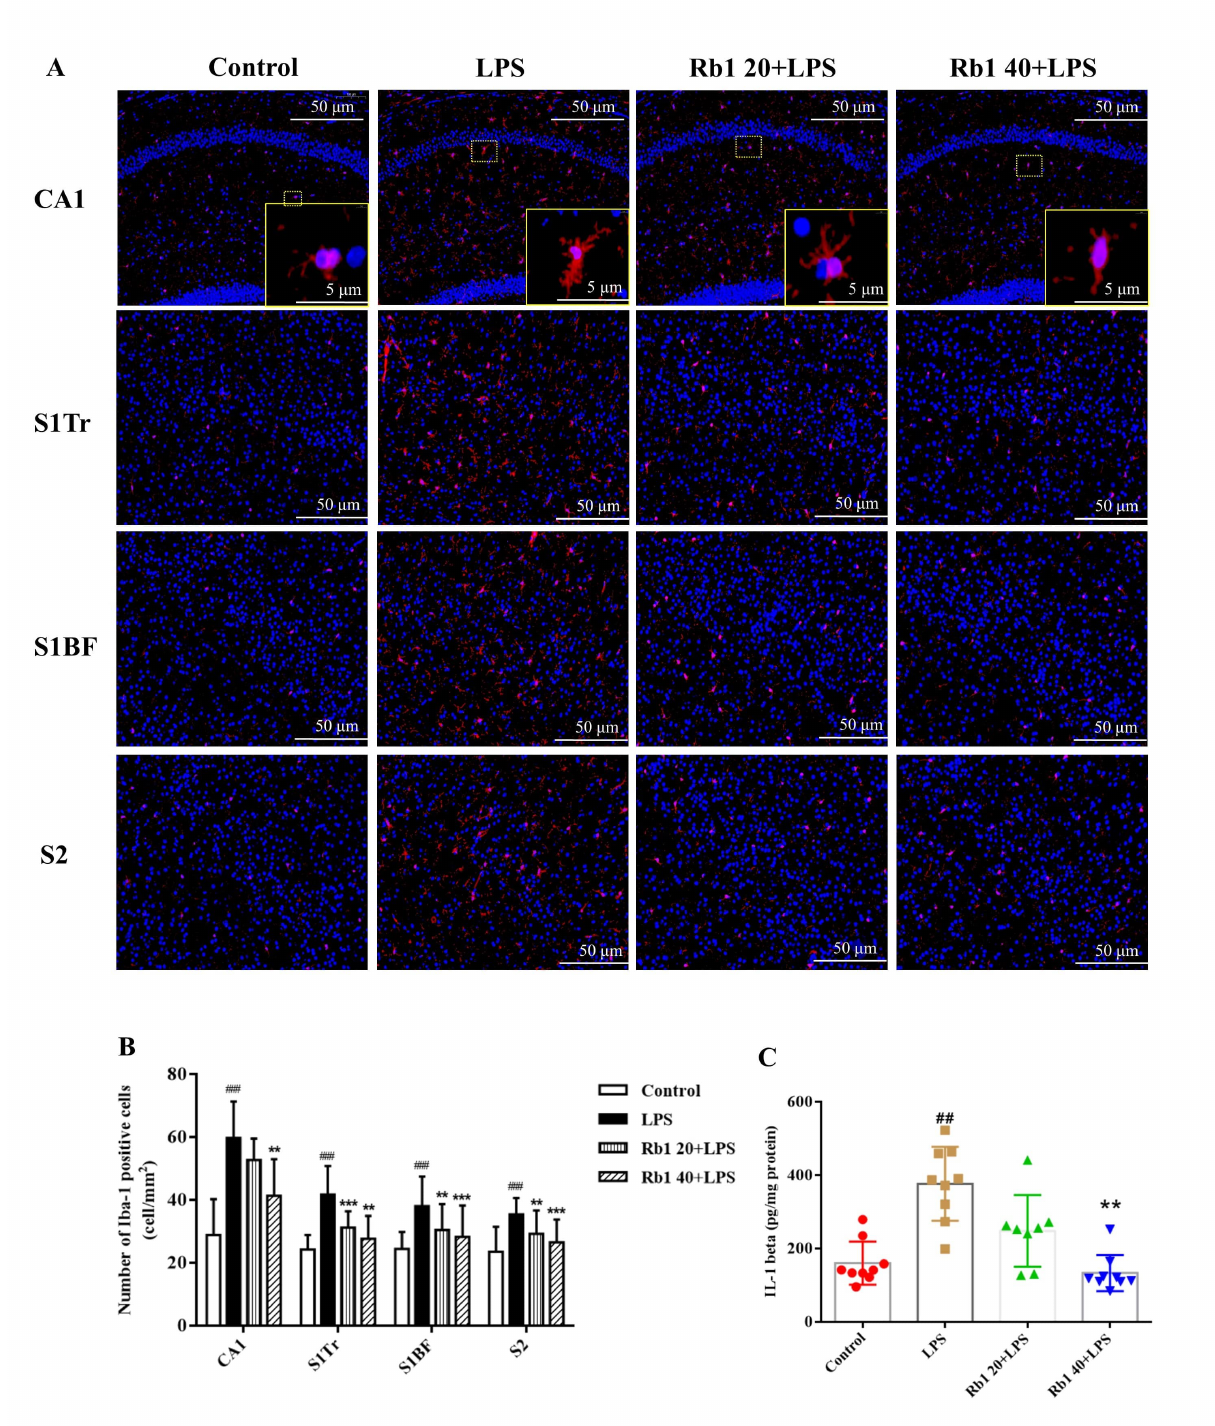
Fig.5. Rb1treatmentsuppressedtheLPS-inducedmicroglialactivationandinhibitedtheproductionofIL-1 β inthebrain. IBa-1 immunostaining and the IL-1 β test were performed 24 h after LPS i.p. injection. The IBa-1 positive cells (Red) were shown in CA1, S1Tr, S1BF, and S2 area (A). The nuclei were stained with DAPI (Blue). The IBA1 cells in CA1, S1Tr, S1BF, and S2 were counted (B). The IL-1 β production in the brain was analyzed with ELISA (C). Data are represented as mean ± SD (n = 6 or 9). ### p < 0.001 versus the control group; ** p < 0.01 and *** p < 0.001 versus the LPS